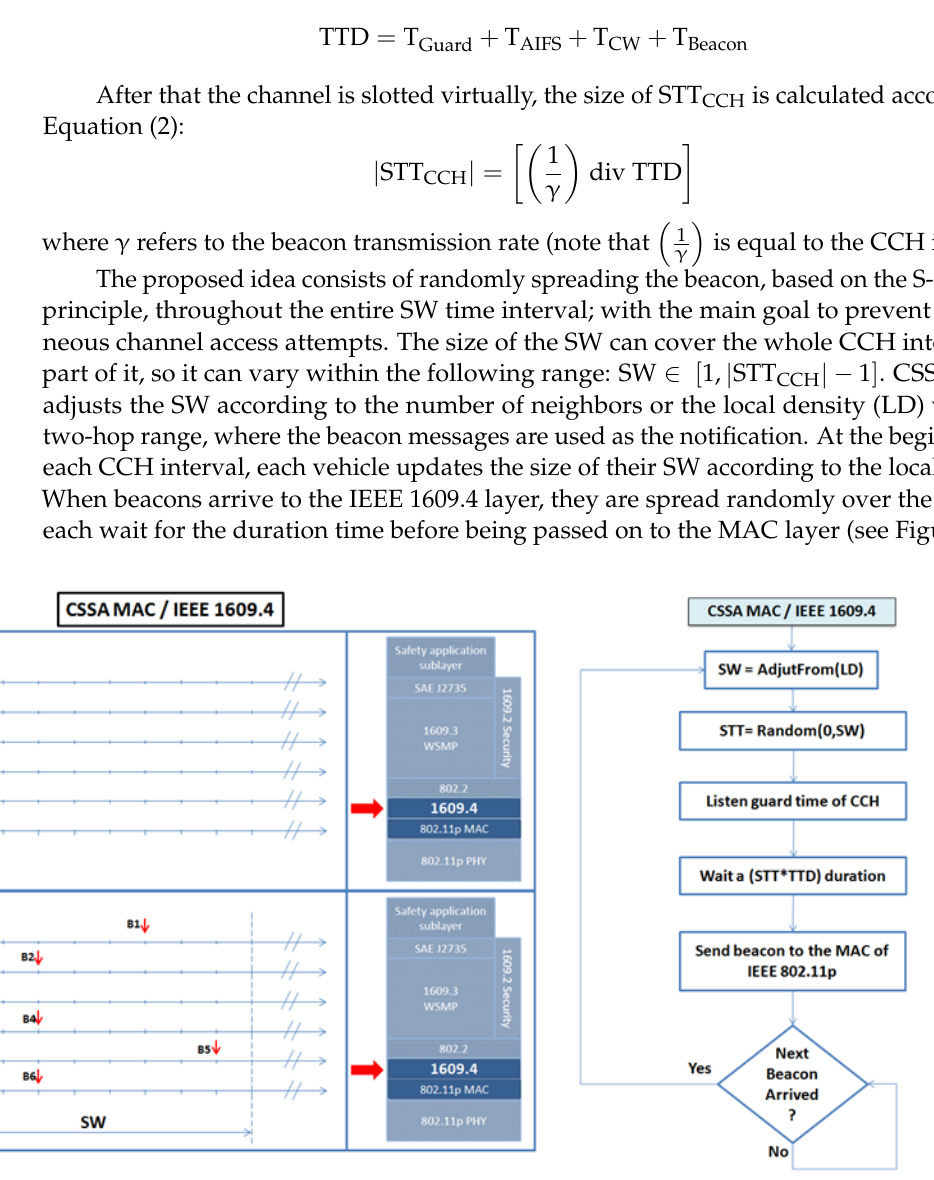
Figure 2. CSSA MAC functioning: ( a ) beacons simultaneously arriving to the IEEE 1609.4 layer; ( b ) beacons being spread over the SW.